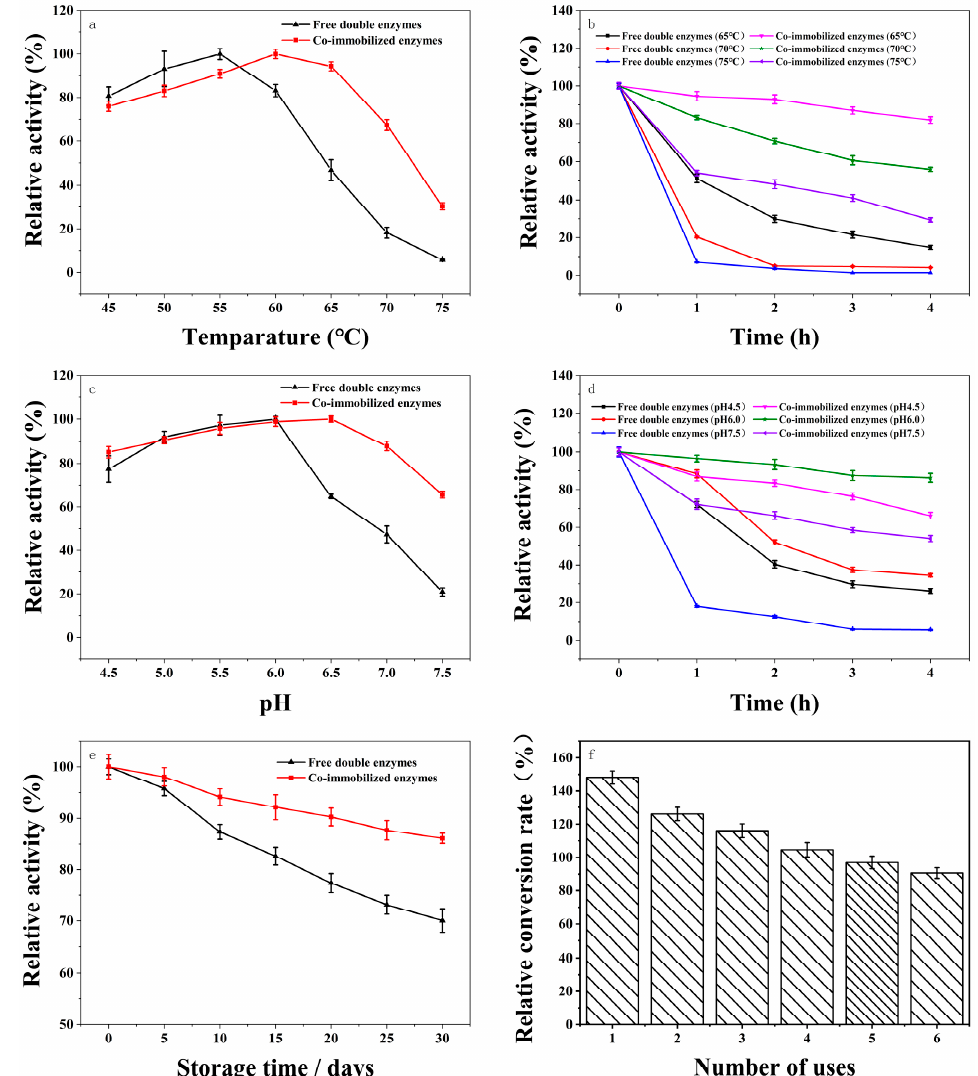
Figure 7. Enzymatic properties analysis of the g-C 3 N 4 /CF co-immobilized double enzyme. ( a ) The optimal reaction temperature changes of the free enzyme and the co-immobilized enzyme; ( b ) thermal stability of the free enzymes and the co-immobilized enzymes; ( c ) optimum pH change of the free enzyme and the co-immobilized enzyme; ( d ) the pH stability of the free enzymes and the co- immobilized enzymes; ( e ) storage stability of the free enzymes and co-immobilized enzymes; ( f ) lactulose relative conversion rate.